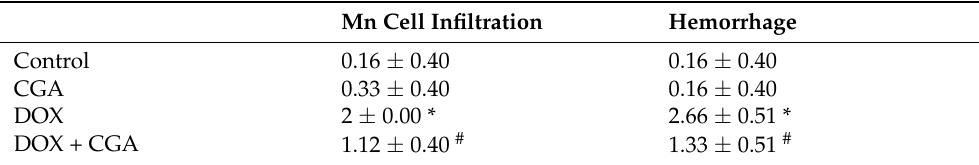
Figure 3. E ff ects of CGA on histopathological changes in DOX-treated cardiac tissue by H&E stain- Figure 3. Effects of CGA on histopathological changes in DOX-treated cardiac tissue by H&E ing (magni fi cation, ×400). ( A ) Control, ( B ) CGA, ( C ) DOX, and ( D ) DOX + CGA. Arrowhead: Mn cell staining (magnification, × 400). ( A ) Control, ( B ) CGA, ( C ) DOX, and ( D ) DOX + CGA. Arrowhead: in fi ltration score, Arrow: Hemorrhage. Data are expressed as the means ± SD. CGA: Chlorogenic Mn cell infiltration score, Arrow: Hemorrhage. Data are expressed as the means ± SD. CGA: acid (100 mg/kg); DOX: Doxorubicin (15 mg/kg). Arrowhead: Mn cell in fi ltration score, Arrow: Chlorogenic acid (100 mg/kg); DOX: Doxorubicin (15 mg/kg). Arrowhead: Mn cell infiltration score, Hemorrhage. Arrow: Hemorrhage. Table 3. Histopathological fi ndings. * p < 0.05 vs. the control group, # p < 0.05 vs. the DOX group. Table 3. Histopathological findings. * p < 0.05 vs. the control group, # p < 0.05 vs. the DOX